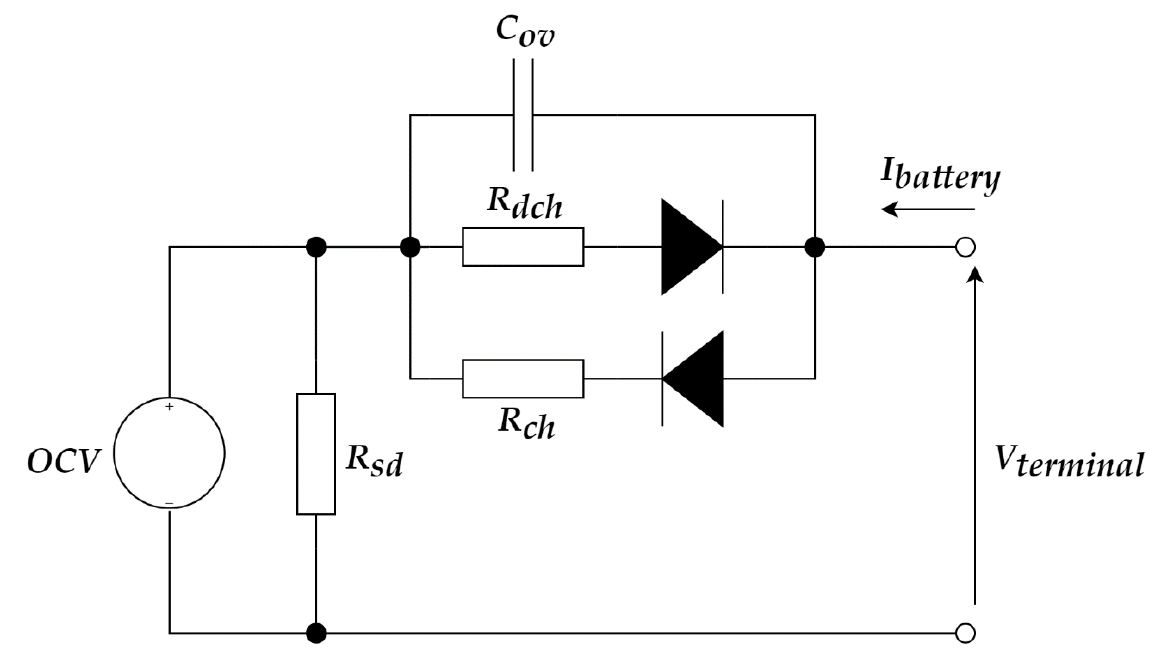
Figure 5. Equivalent circuit topology of the model used for lead – acid battery cell.